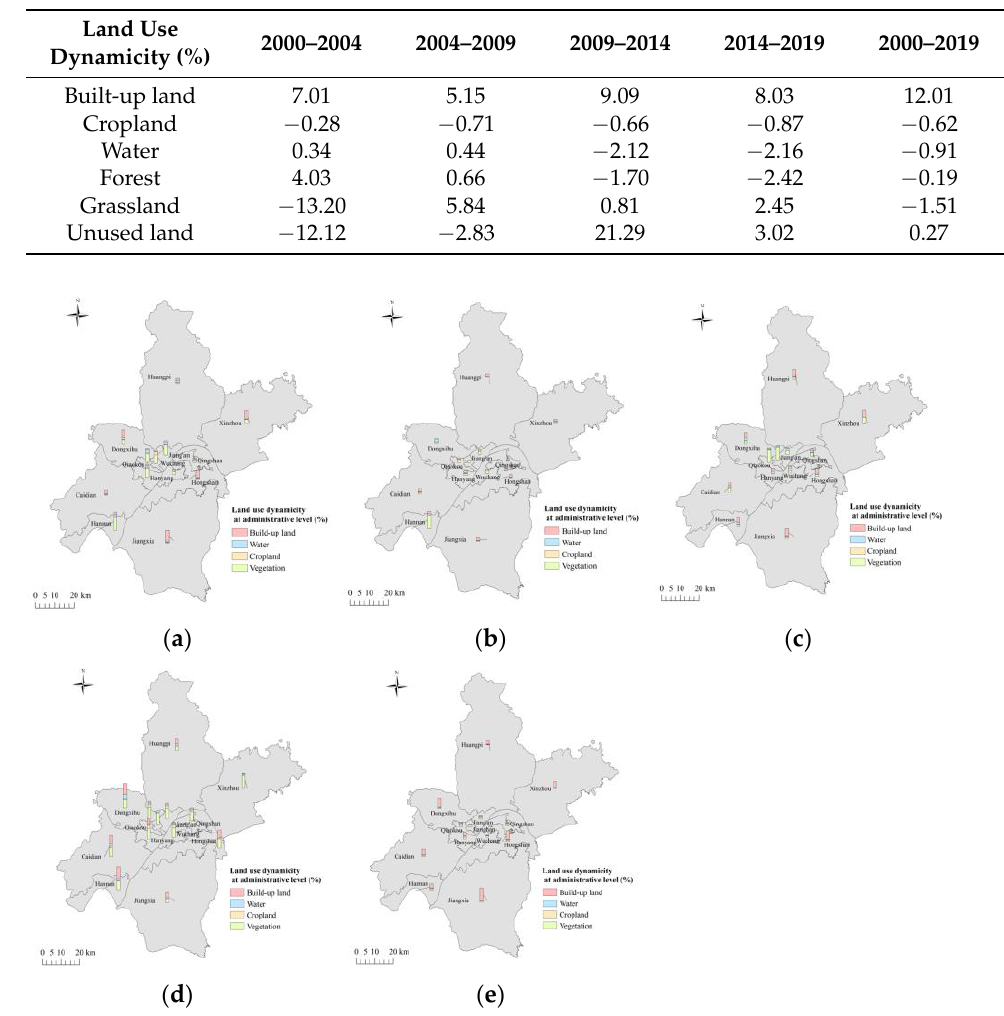
Table 5. Single land use dynamicity of Wuhan City in different periods.